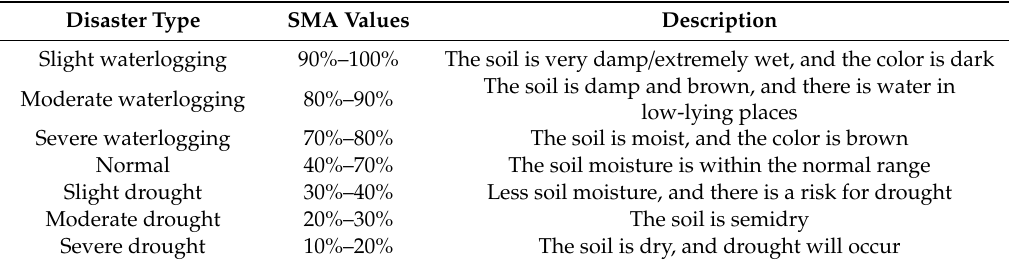
Table 1. Definitions of disaster levels.